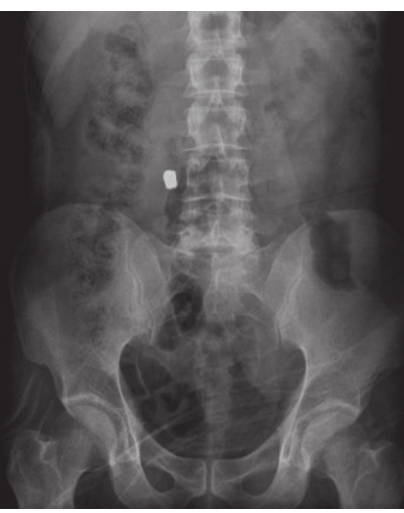
Figure 1: Bullet seen on the anterior-posterior radiograph.